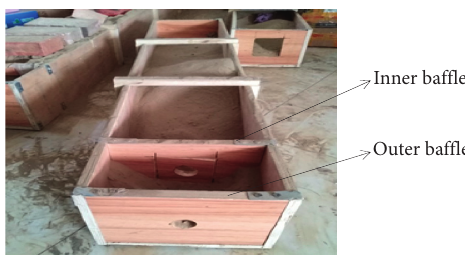
Figure 1: Laboratory model chamber for the test.